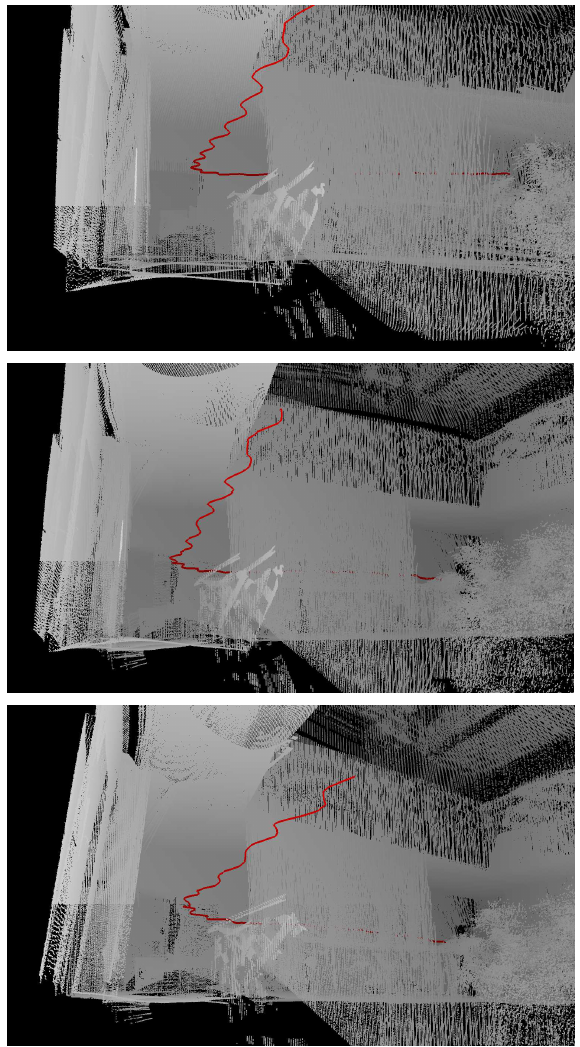
Figure 6. Top: “unwound” 3D point cloud. Bottom: Optimized point cloud using semi-rigid SLAM. Center: Intermediate